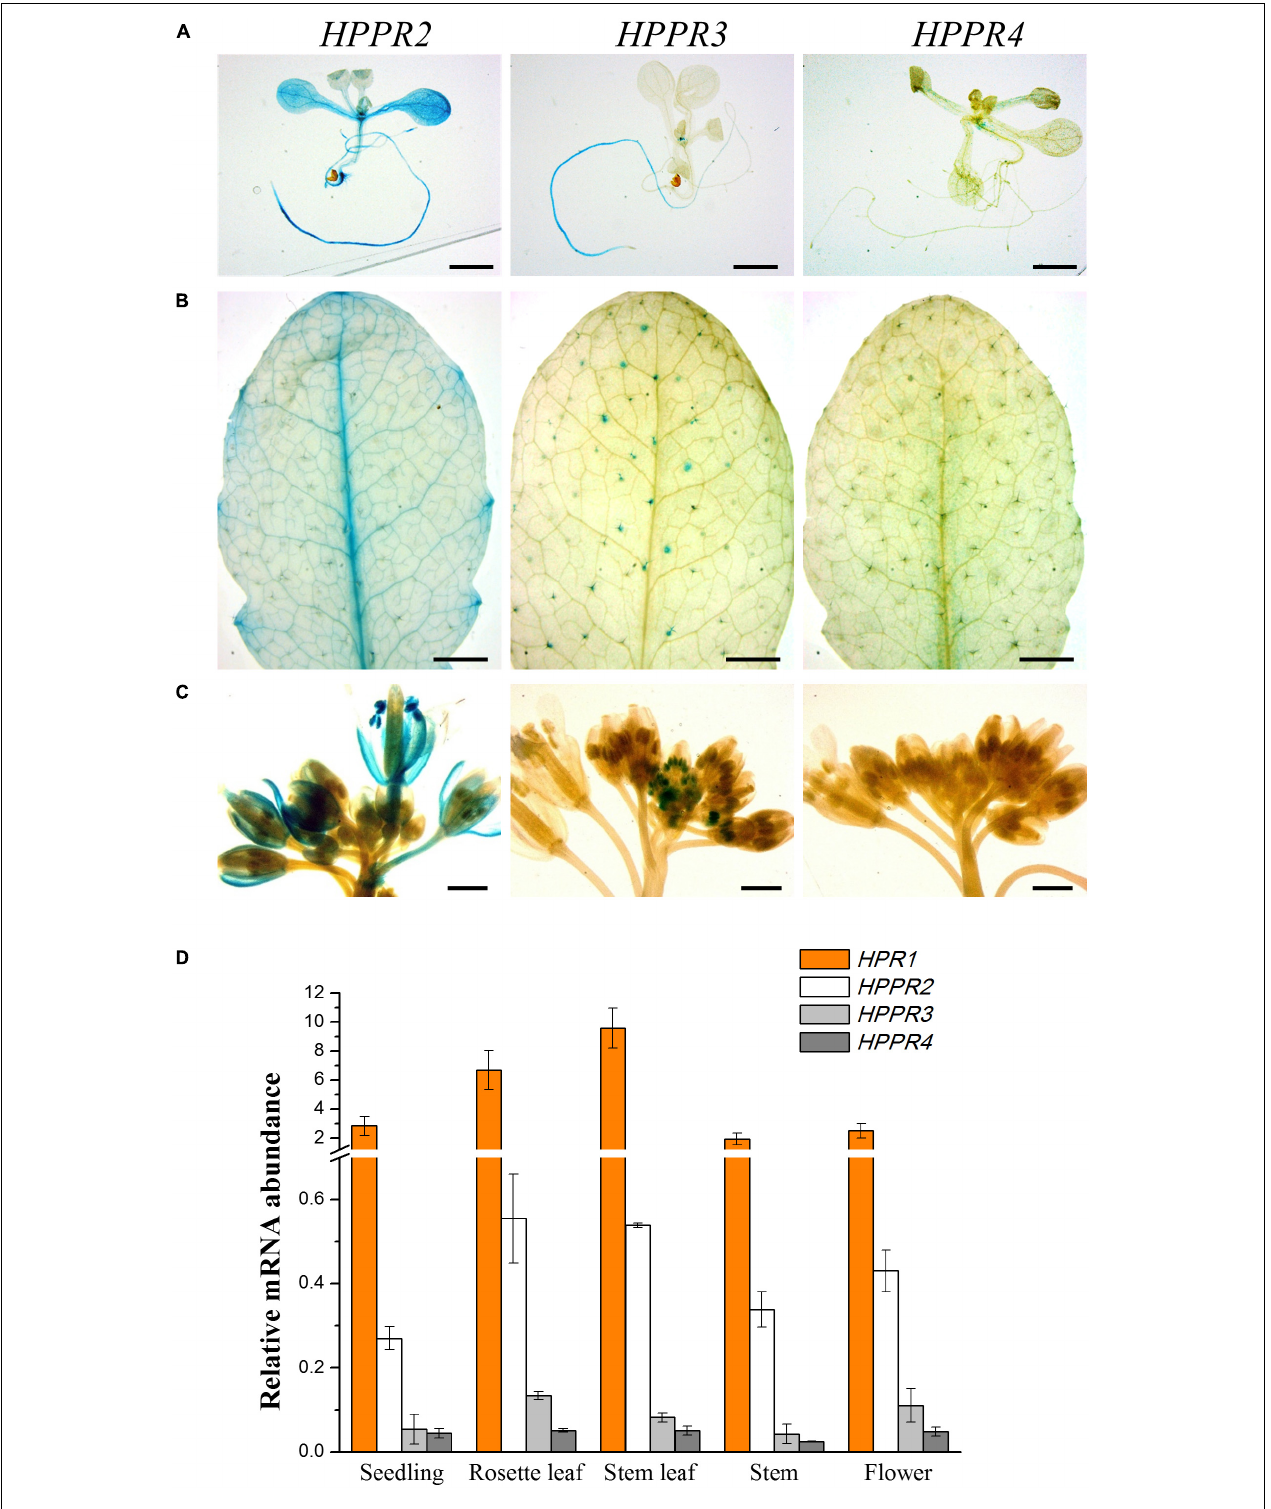
FIGURE 5 | Expression patterns of the HPPR genes in plants. (A–C) , staining assay of the GUS activities driven by the different HPPR gene promoters. (A) 9-day-old seedling. (B) 4-week-old rosette. (C) Inflorescence from a 5-week-old plant. Bars in (A) and (B) = 2 mm; bars in (C) = 1 mm. (D) The relative expression levels of HPR1 , HPPR2 , HPPR3 , and HPPR4 in different organs were analyzed by quantitative reverse transcription PCR (qRT-PCR), with PP2AA3 (At1g13320) as the internal reference. Data are means of three biological replicates ± SE.